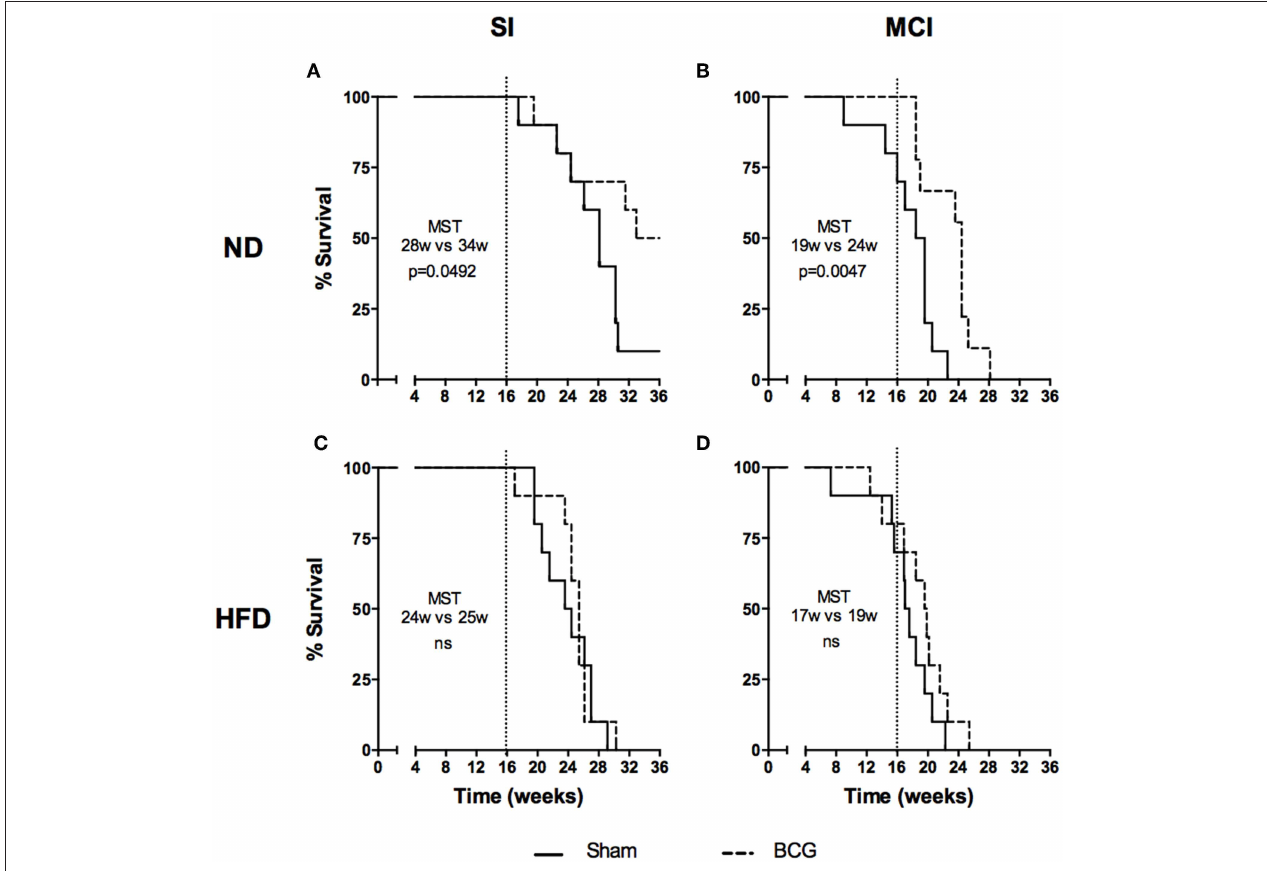
FIGURE 6 | Evolution of survival after Mtb infection for the first experiment. Each panel compares sham and BCG vaccinated groups: ND and SI (A) , ND and MCI (B) , HFD and SI (C) , HFD and MCI (D) . Median survival times and p -values are indicated in each panel. Log-rank